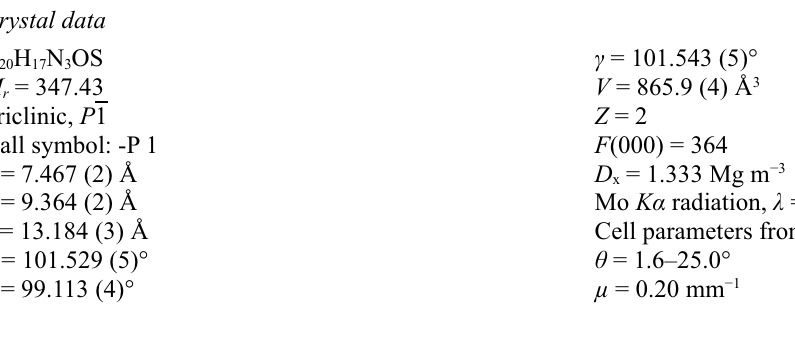
A packing diagram of (I) viewed down the a axis. Hydrogen bonds are shown by dashed lines. N -(Biphenyl-4-ylcarbonyl)- N ′